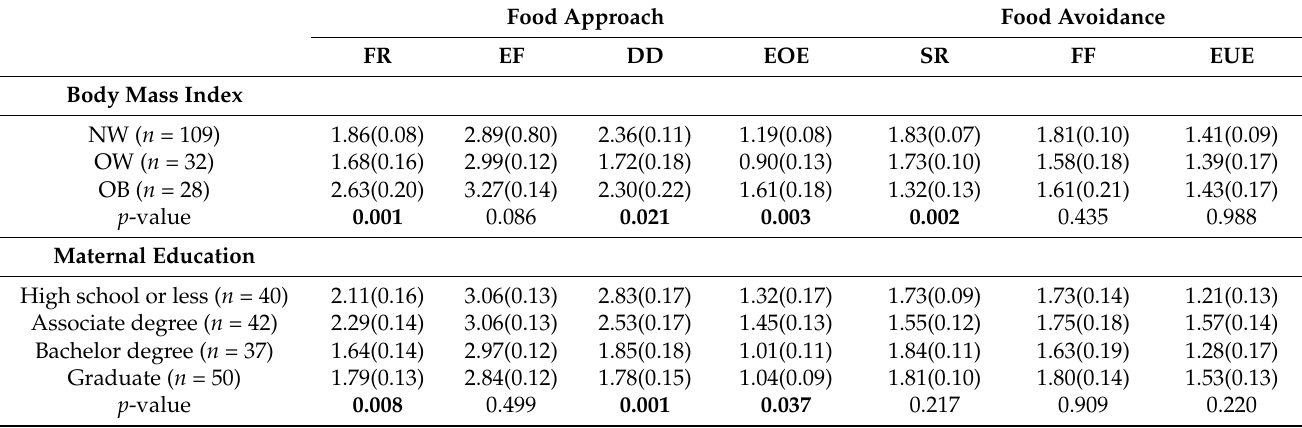
Table 4. One-way ANOVA of factors based on body weight and maternal education. Food